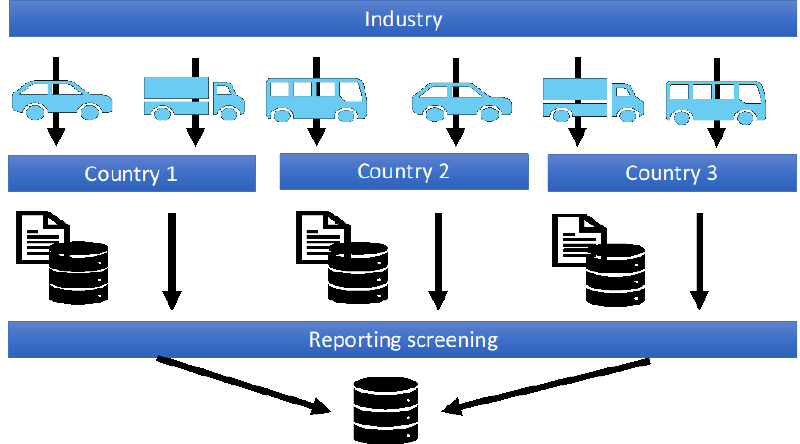
Figure 4. Reporting Mechanism, authors’ own elaboration based on [6].